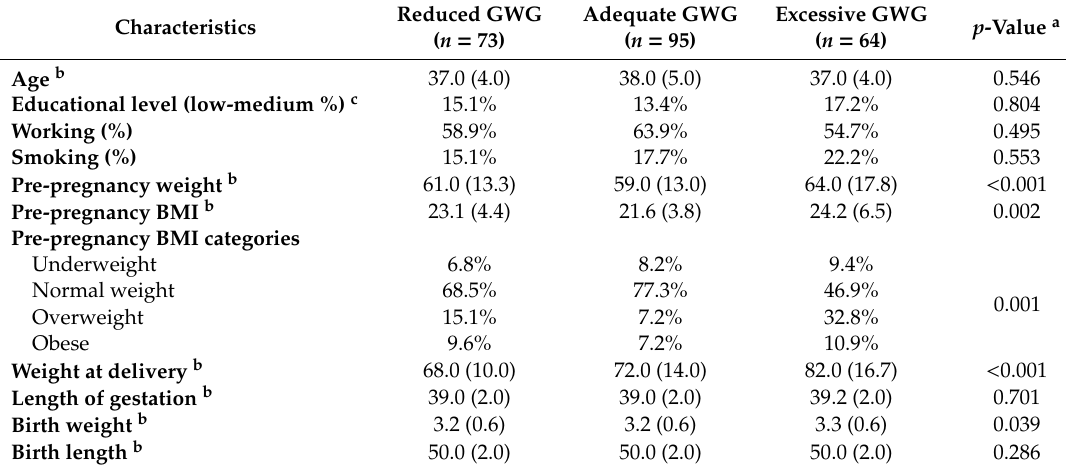
Table 1. Characteristics of women from the “Mamma & Bambino” cohort ( n = 232) according to gestational weight gain